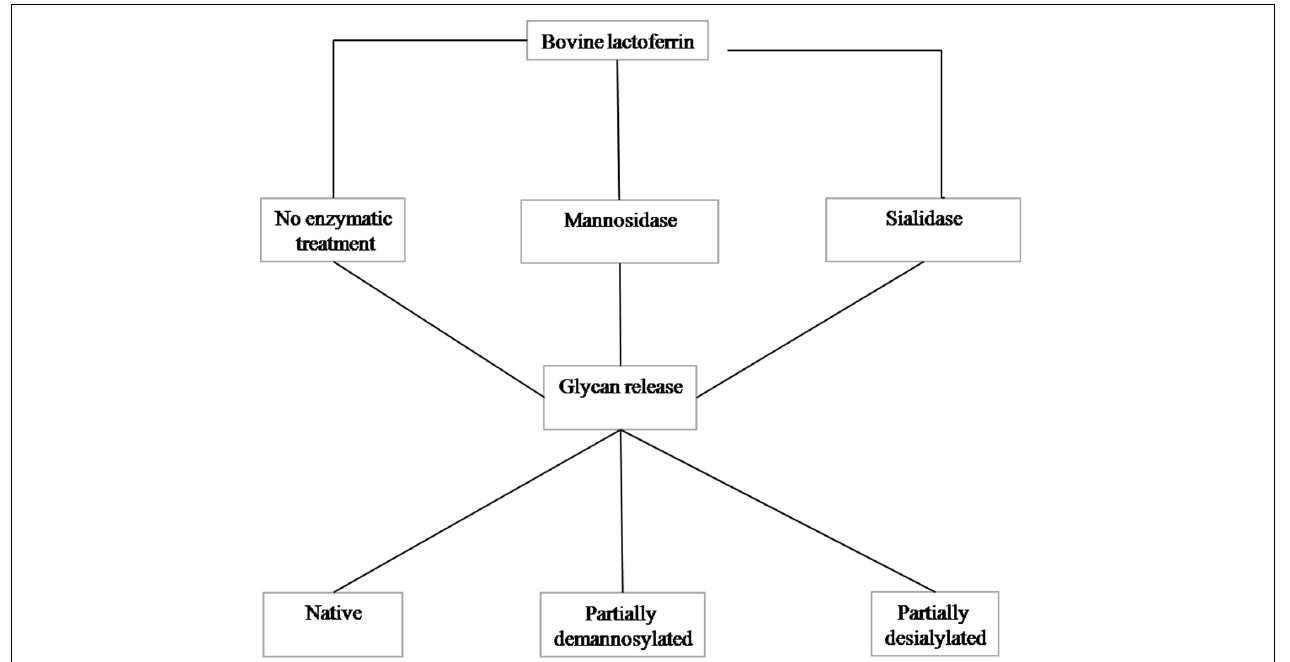
FIGURE 1 | Schematic representation of the preparation of the N -glycan